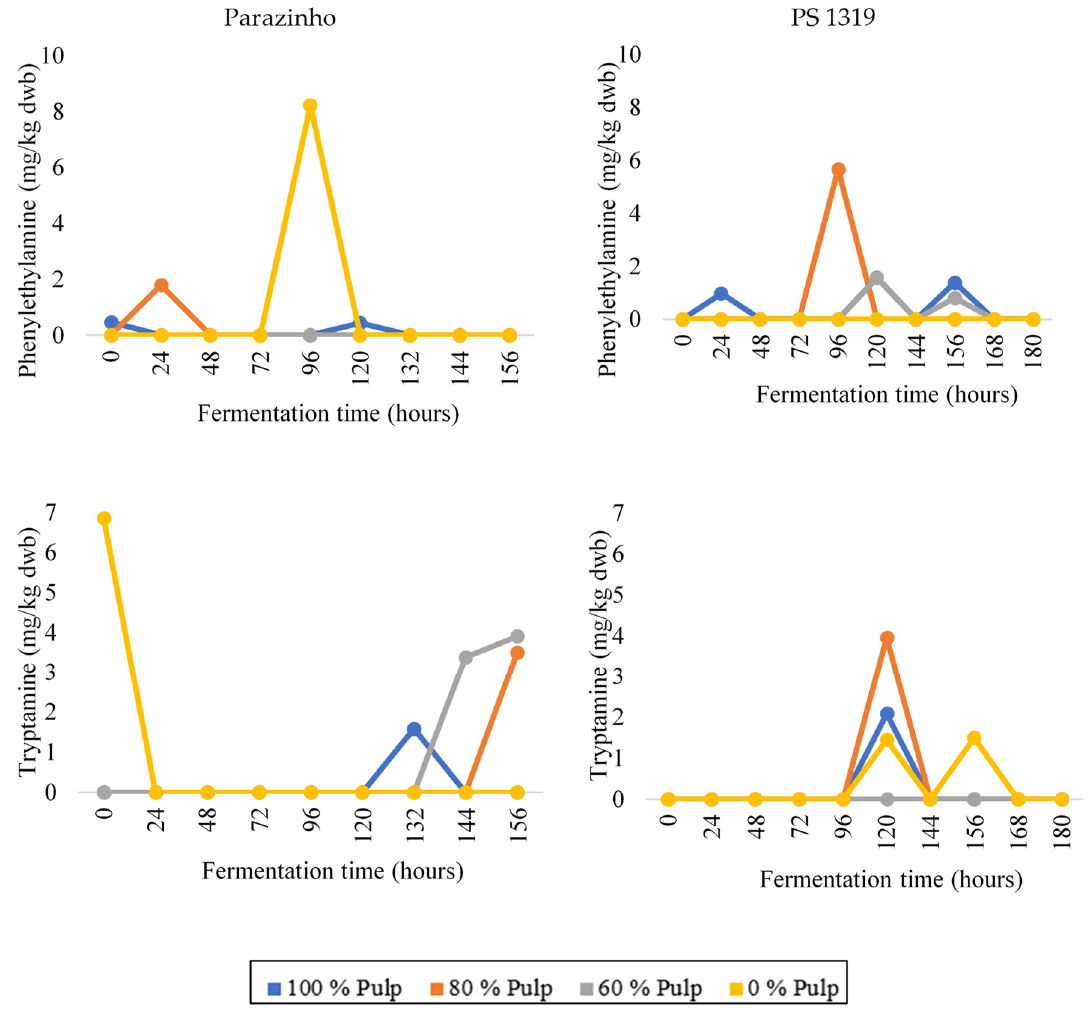
Figure 5. Changes in the levels of tryptamine and phenylethylamine during on-farm fermentation of two varieties of cocoa (PS 1319 and Parazinho) from Bahia, Brazil, using different proportions of pulp (100, 80, 60, and 0%).